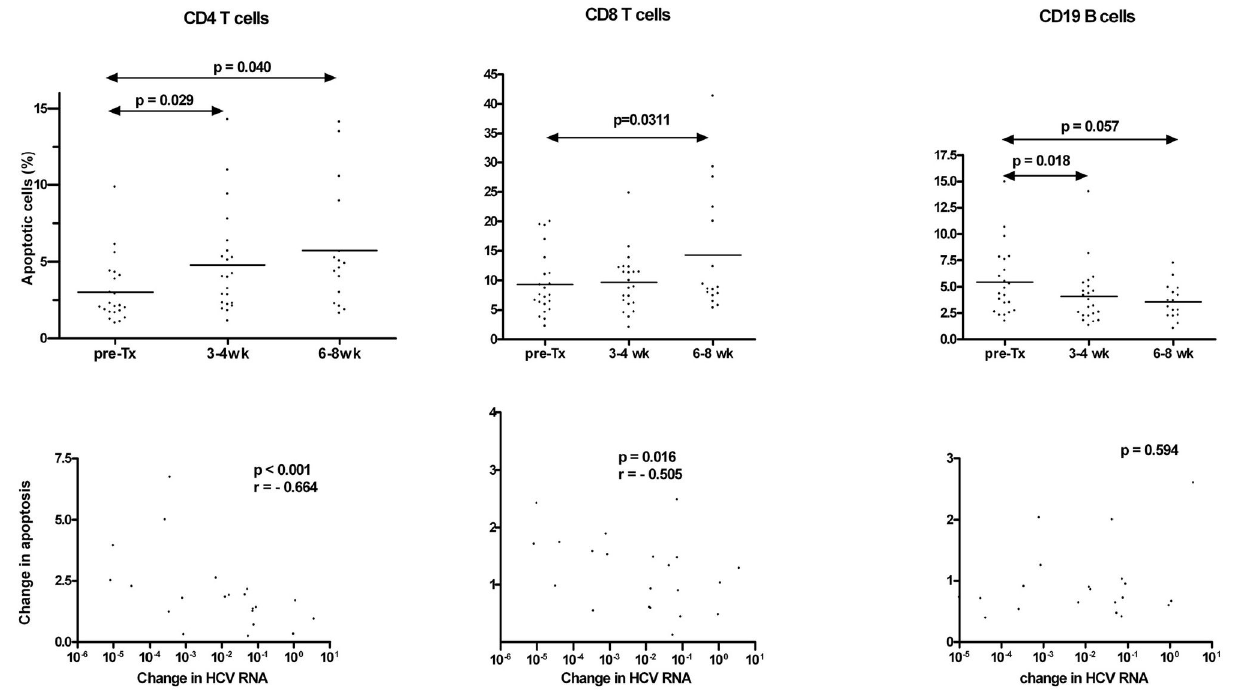
Figure 1. Changes in CD4+, CD8+ and CD19+ cells apoptosis in 22 HCV/HIV coinfected patients treated with pegylated interferon and ribavirin. Apoptosis was assessed by Annexin V staining and flow cytometry. Patients were tested right before initiation of treatment and after 3-4 weeks. In 16 patients testing was repeated 6-8 weeks from the initiation of treatment. Apoptosis of CD4+ and CD8+ T cells increased during therapy, while apoptosis of CD19+ B cells decreased. doi: